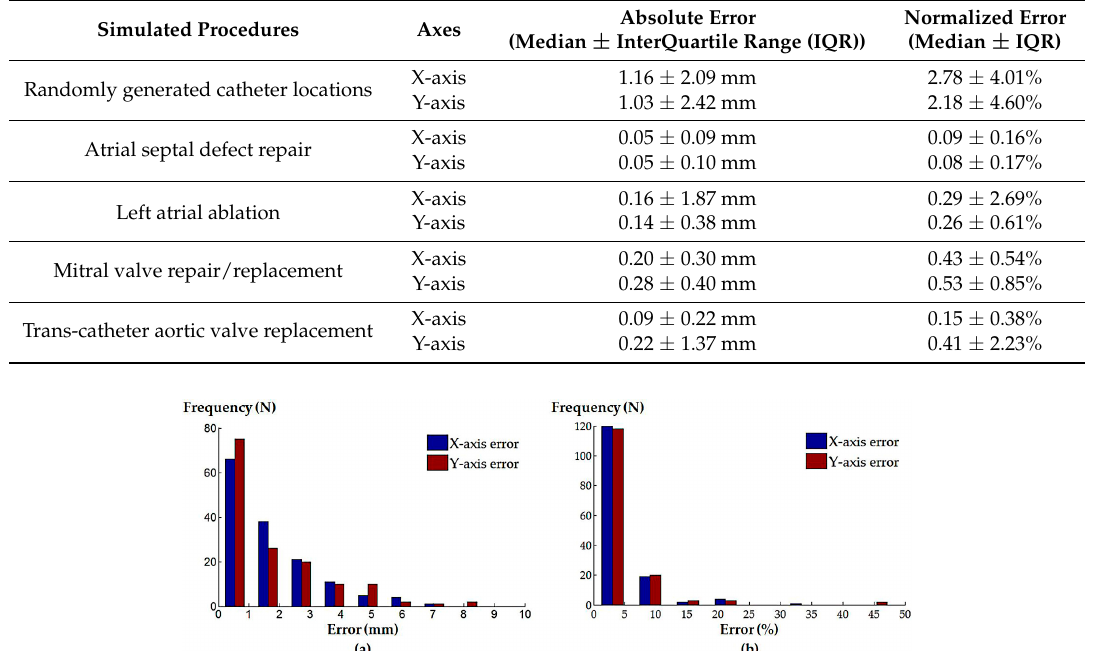
Table 1. Summary of the simulation experiment results for the localized adjustment step with the catheter tip positions defined from randomly generated positions and simulated clinical procedures.